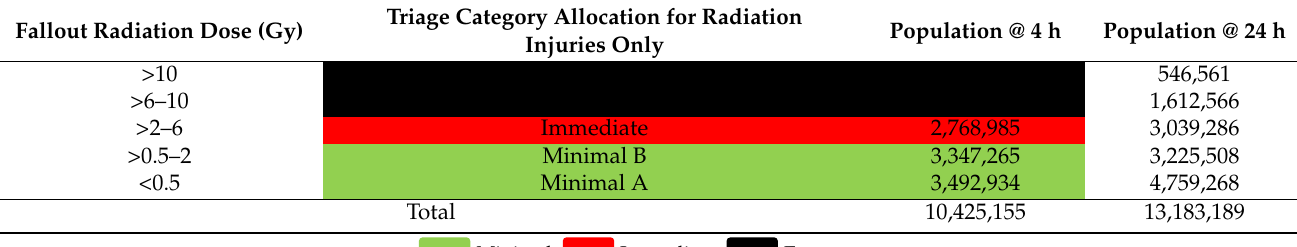
Table 5. Human casualties from fallout radiation only (1 × 25 kt nuclear weapon).